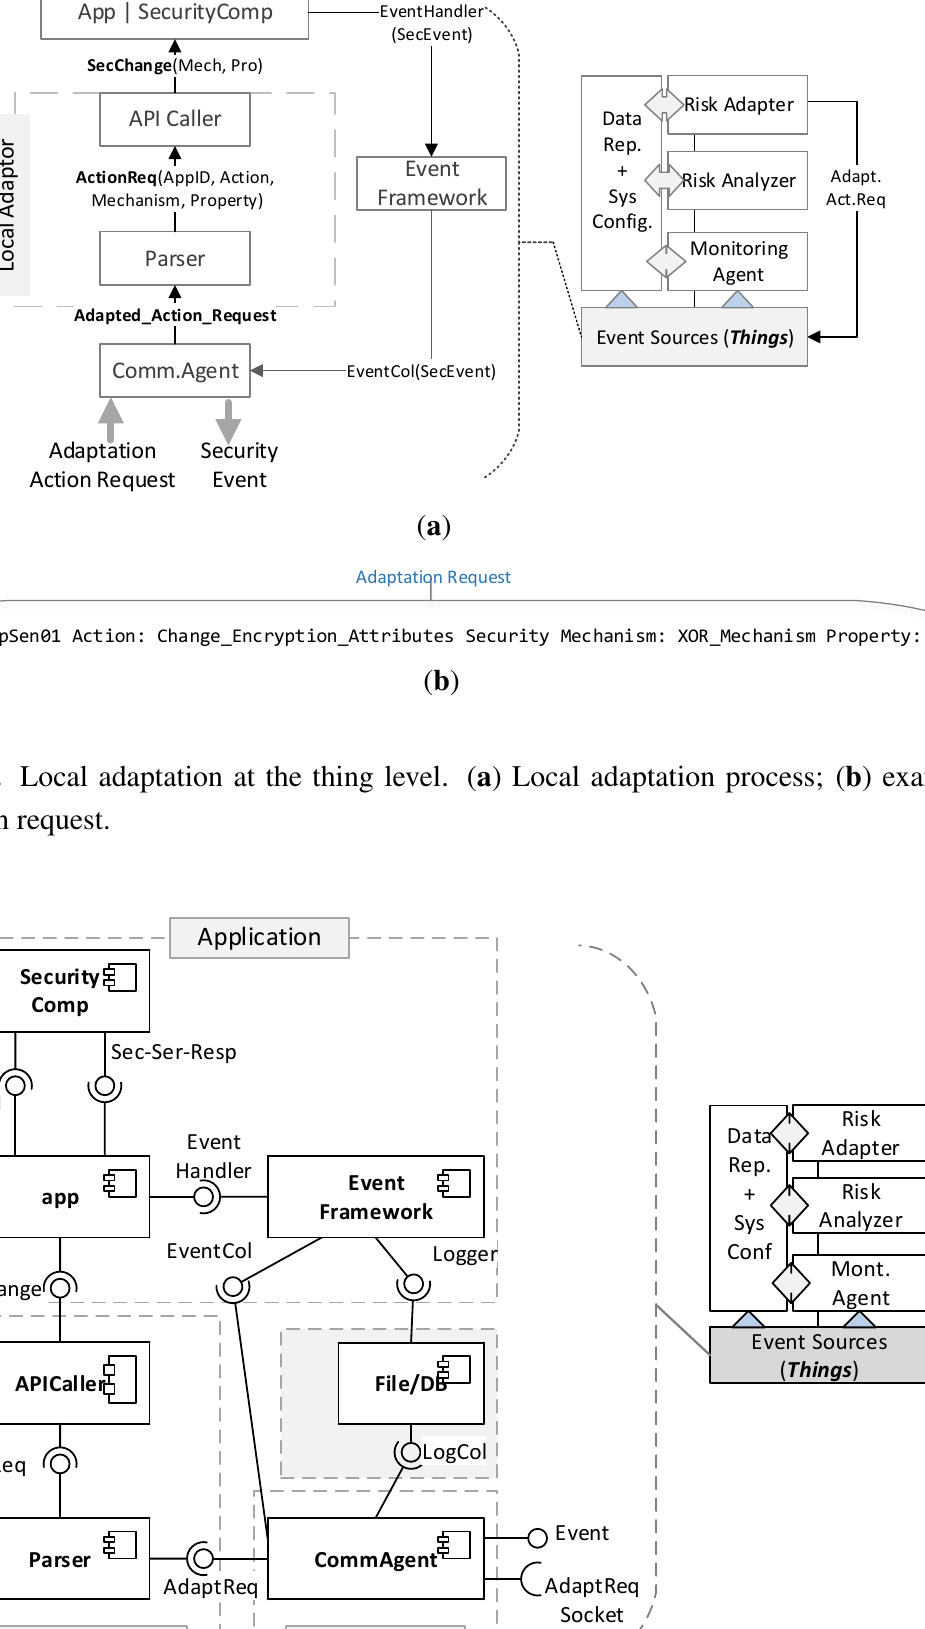
Figure 6. Event source component